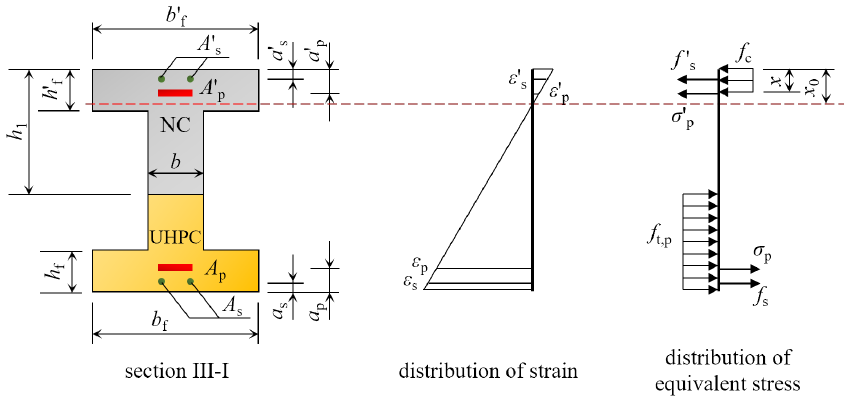
Figure 3. Calculation diagram for cross-section III-I.